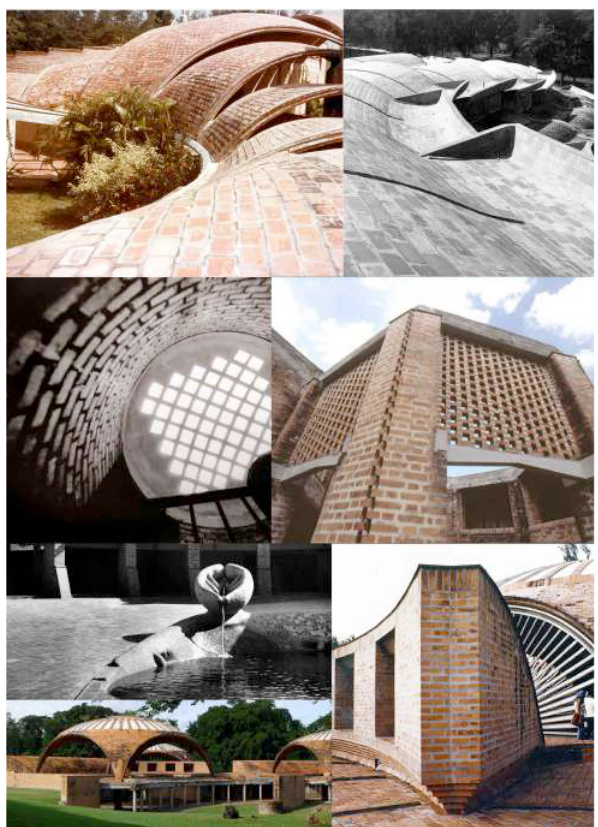
Figure 2. National Art Schools of Havana (Del Curto,